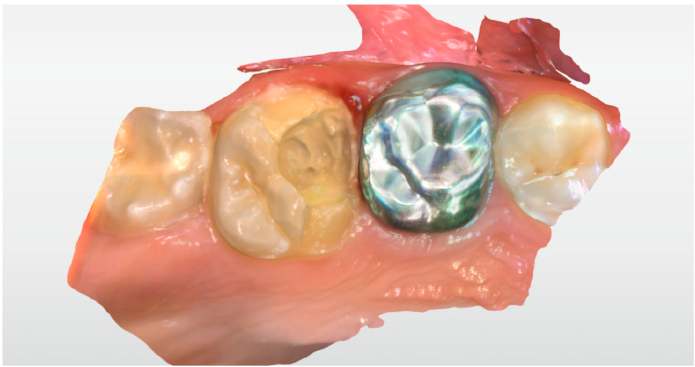
Figure 4. A scan of tooth #16 after tooth preparation.